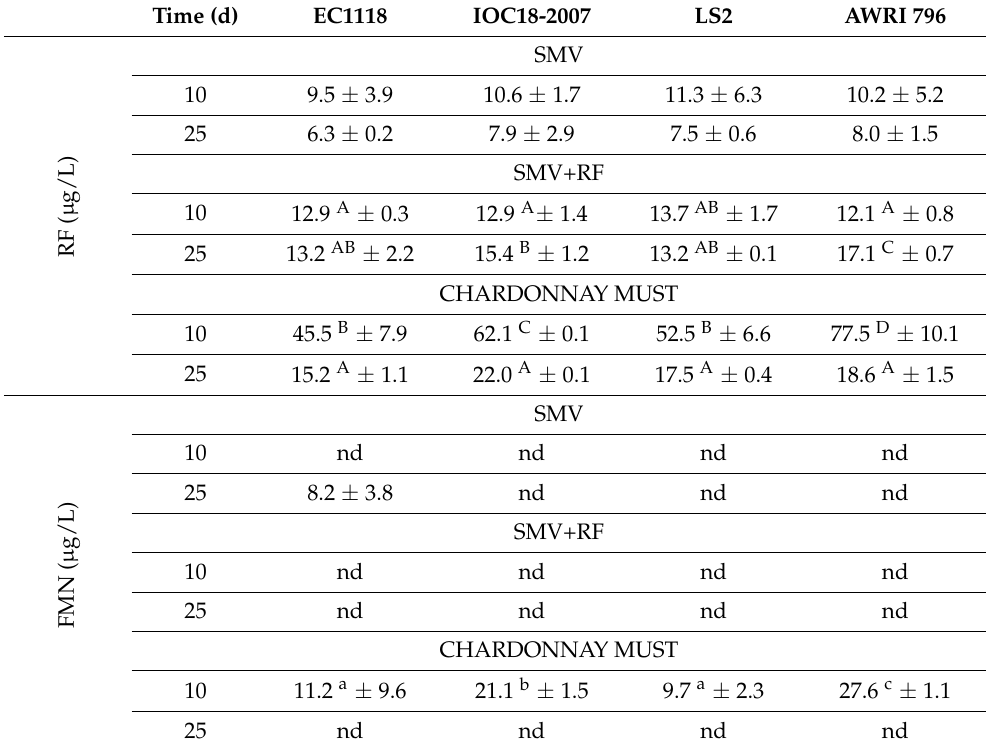
Figure 4. Scatter plot of the PCA analyses regarding the extracellular content of FDs. Table 1. Intracellular content of FDs during the yeast growths in the three cultural media. Reported data are mean values of three replicates with the standard deviation. Capital, lowercase, and greek letters are used for RF, FMN, and FAD content, respectively. Different letters correspond to significant differences ( p < 0.05) among the strains grown in the same medium. nd = below the threshold limit of